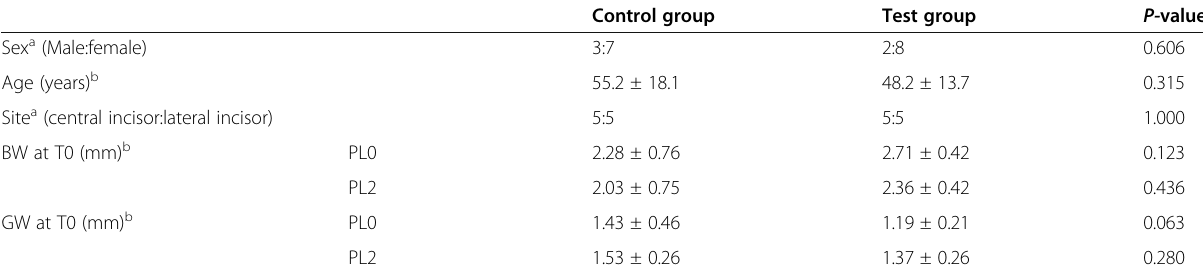
Table 1 Patient demographics and initial horizontal bone and soft tissue thickness per study group Control group Test